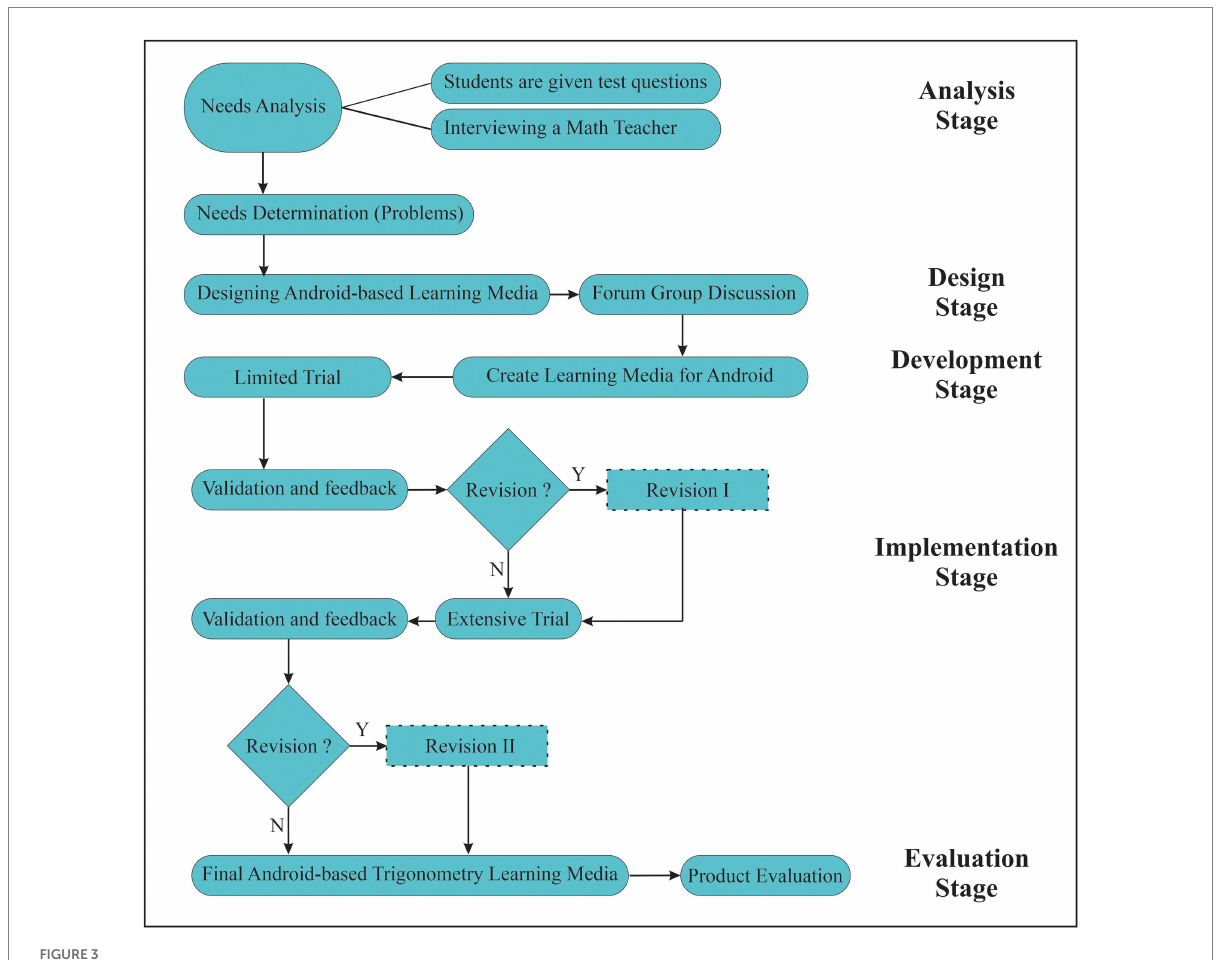
FIGURE 3 Flow of research and development